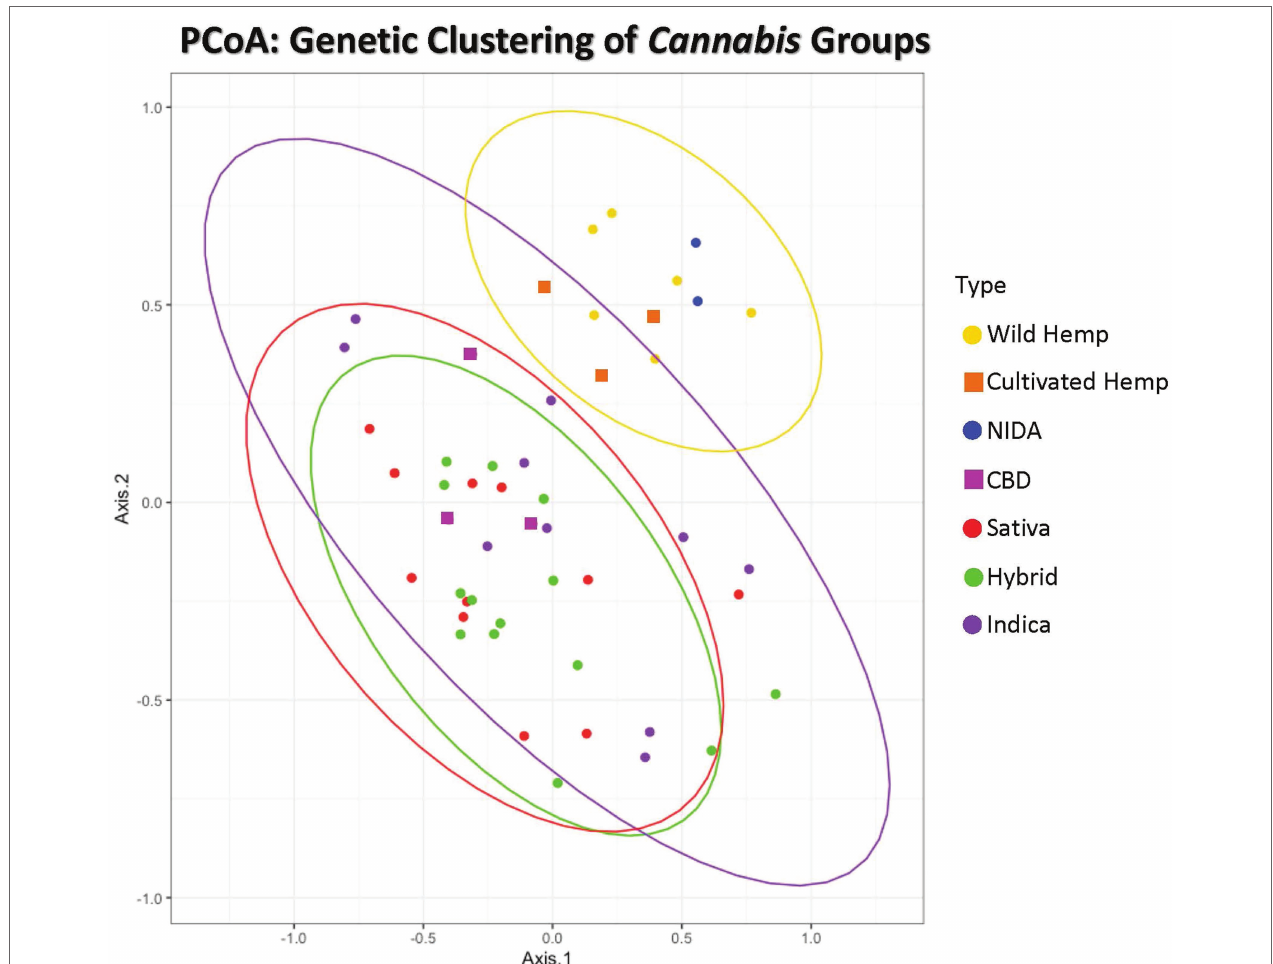
FIGURE 2 | Principal Coordinates Analysis of genetic distance among samples. Samples clustering together are more closely related. The ellipses represent 95% confidence intervals for each group (Cultivated hemp = orange, Wild hemp = yellow, NIDA = blue, High CBD = pink, Sativa = red, Hybrid = green, Indica = purple). Approximately 24% of the genetic variation in these groups is shown (coordinate 1= 13.02% and coordinate 2 = 11.17%). No confidence intervals were drawn for NIDA, High CBD, or Cultivated Hemp samples due to the small sample size (n = 2, n = 3, and n = 3,